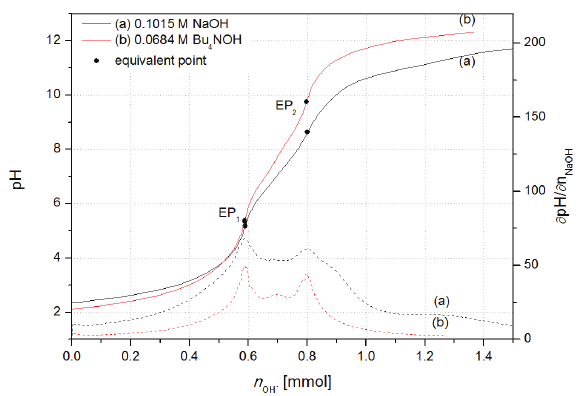
Figure 2. Titration of 0.1061 mmol H OH and (b) 0.0684 M Bu ponding derivatives ∂ pH/ ∂ n